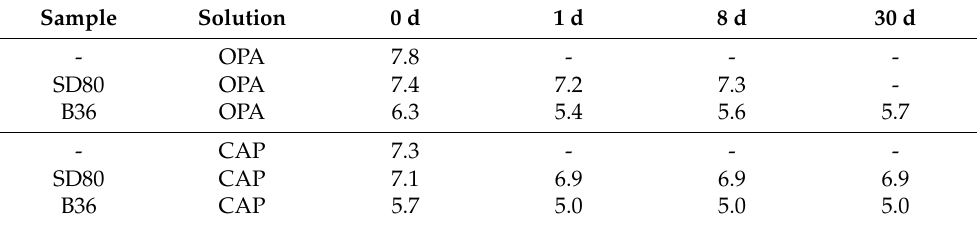
Table 6. Results of pH short-term measurements of both bentonites (SD80, B36) in a glove box at 25 ◦ C with a solid to solution ratio of 1:2. The pH values of both solutions (OPA, CAP) without bentonite are also used as a reference for long-term